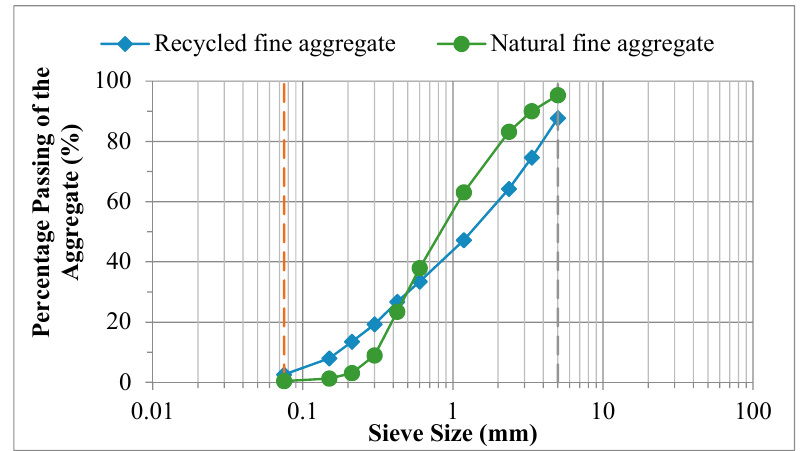
Figure 5. Sieving analysis of NCA and RCCA.